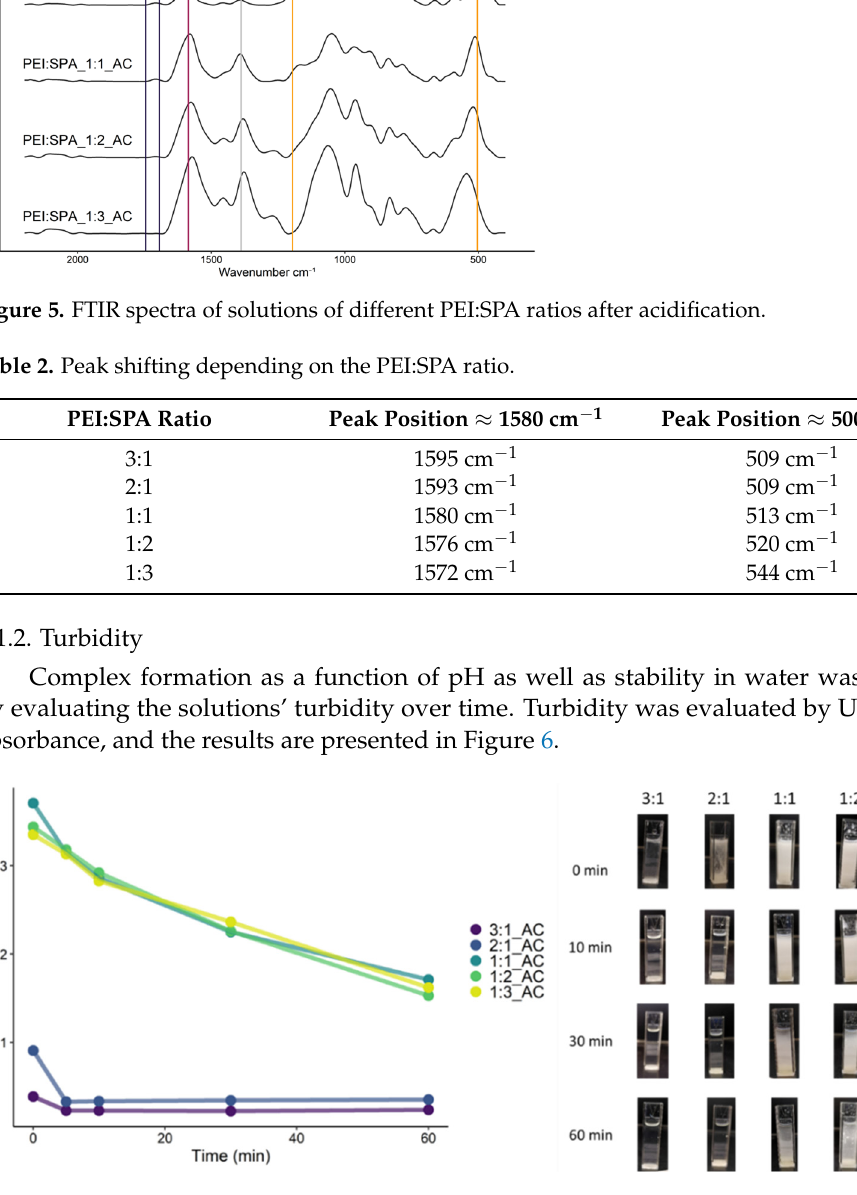
Figure 6. Absorbance over time for PECs after acid